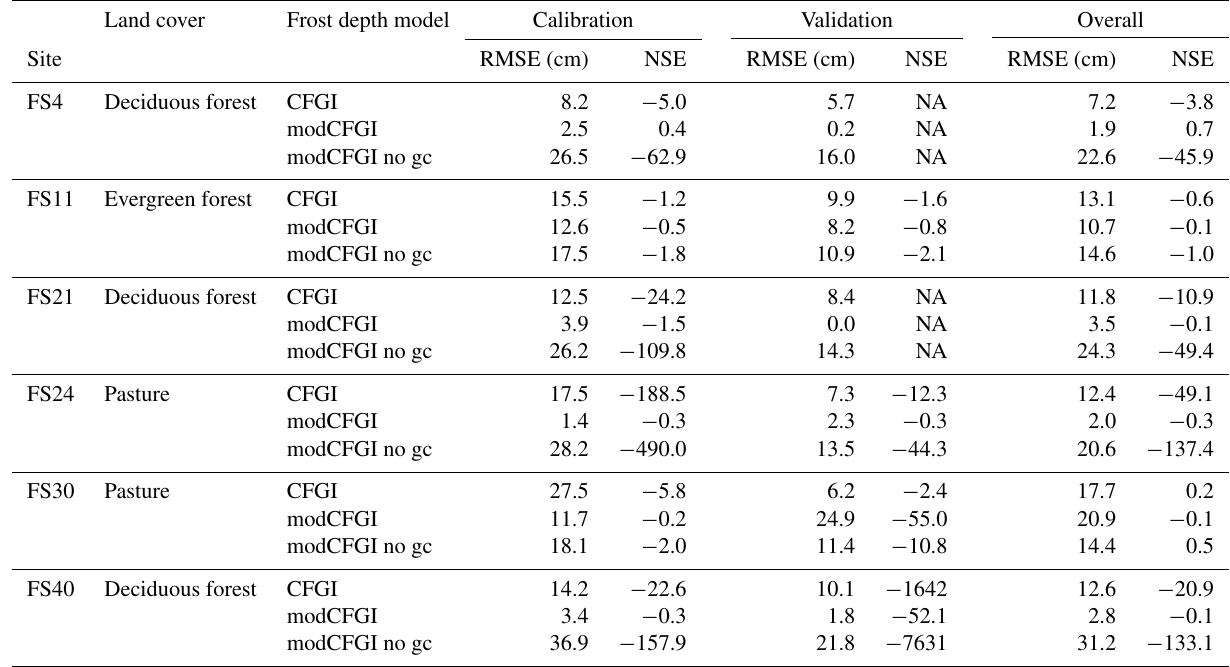
Table 5. Statistics for CFGI and modCFGI frost depth at all six frost sites. Values are shown for calibration period (WY 2006–2007), validation period (WY 2008–2010), and overall (WY 2006–2010). RMSE values closer to zero and NSE values closer to one indicate better fit. No frost was present at FS4 and FS21 during the validation period, resulting in an inability to calculate NSE. Statistics for a recalibrated